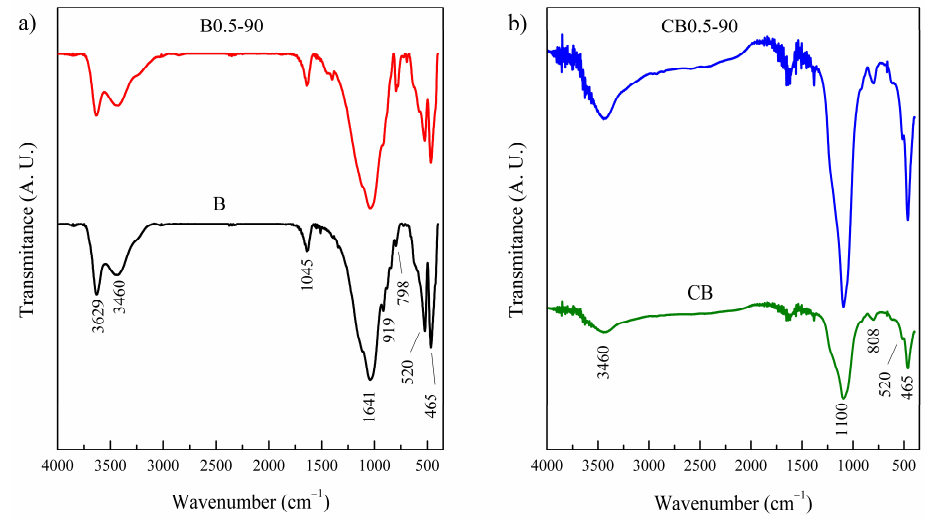
Figure 5. FTIR spectra of the solids. ( a ) Spectra of the bentonite B and the acidified solid B0.5-90; ( b ) spectra of the silica-resin-bentonite nanocomposite CB and the acidified solid CB0.5-90.